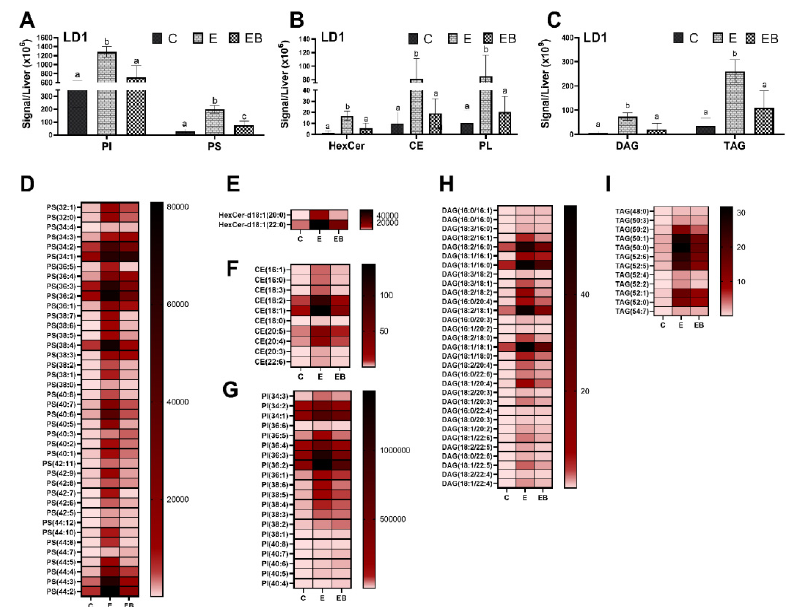
Figure 4. Effects of ethanol and betaine on the lipid species in LD1 fraction isolated from livers of rats fed control (C), ethanol (E), or betaine-supplemented ethanol (EB) diet. ( A ) Phosphatidylinositol (PI) and phosphatidylserine (PS). ( B ) Hexosylceramides (HexCer), cholesteryl esters (CE), and phospholipids (PL). ( C ) Diacylglycerols (DAG) and triacylglycerol (TAG) lipid species identified in LD1 were plotted according to the signal per liver. Data are presented as the mean ± SEM ( n = 8); values not sharing a common letter significantly differ from each other at p ≤ 0.05. Panels ( D – I ) are data presented as heatmap showing the relative distribution of each lipid species in LD1. Each row represents the normalized intensities of a unique chromatographic feature. The features are color coded by row with dark brown indicating high intensity, brown indicating low intensity, and light pink indicating below limit of detection.